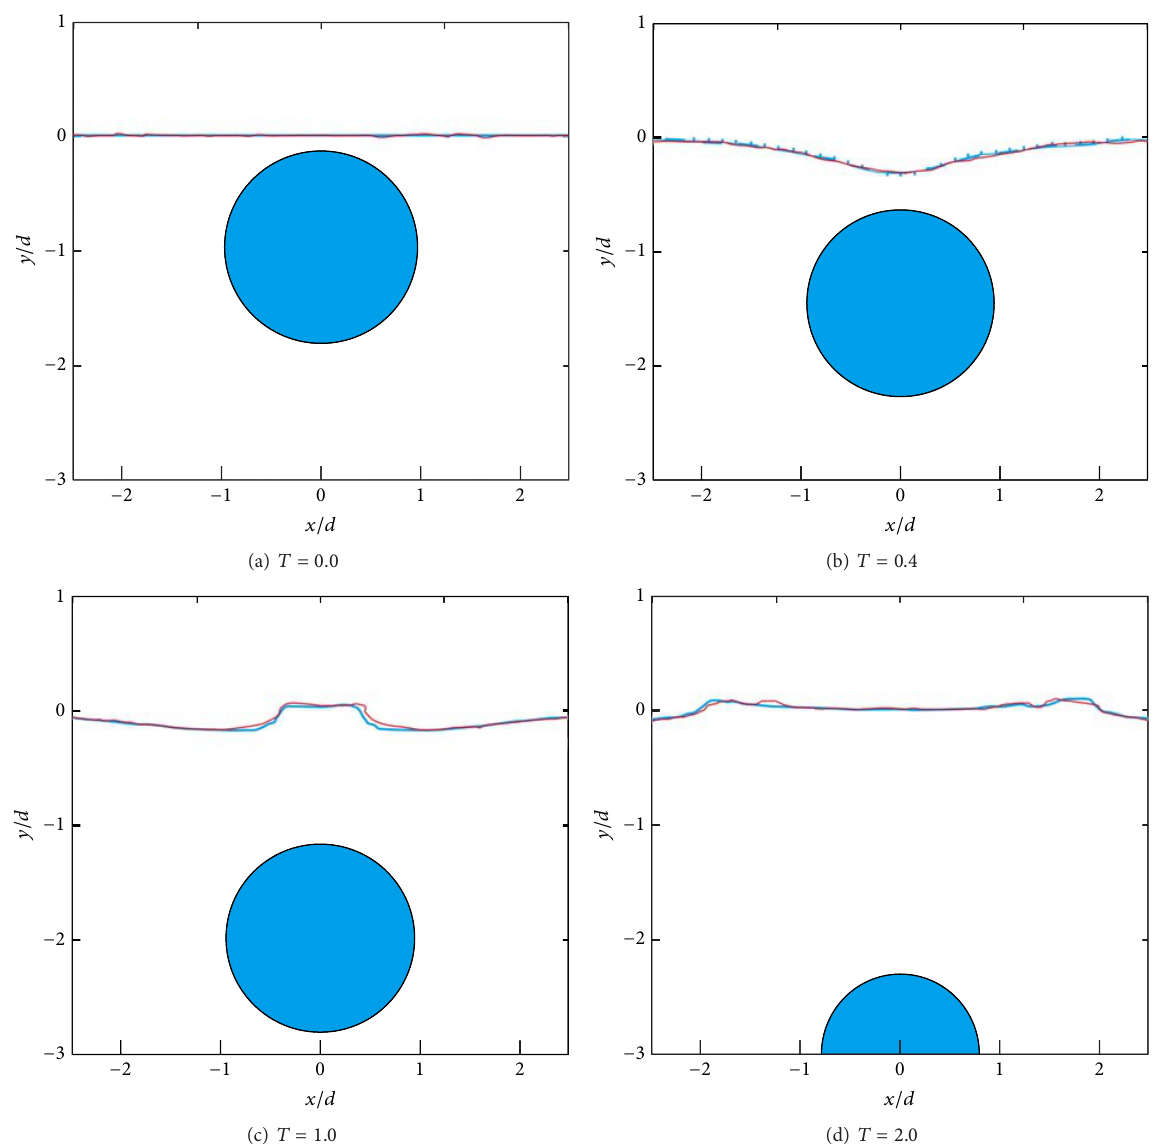
Figure 4: Comparisons of results by different models of a circular cylinder sinking in calm water: the present results (red solid line); Lin’s results (blue solid line); Greenhow et al.’s results (dashed line); Tyvand et al.’s results (dotted